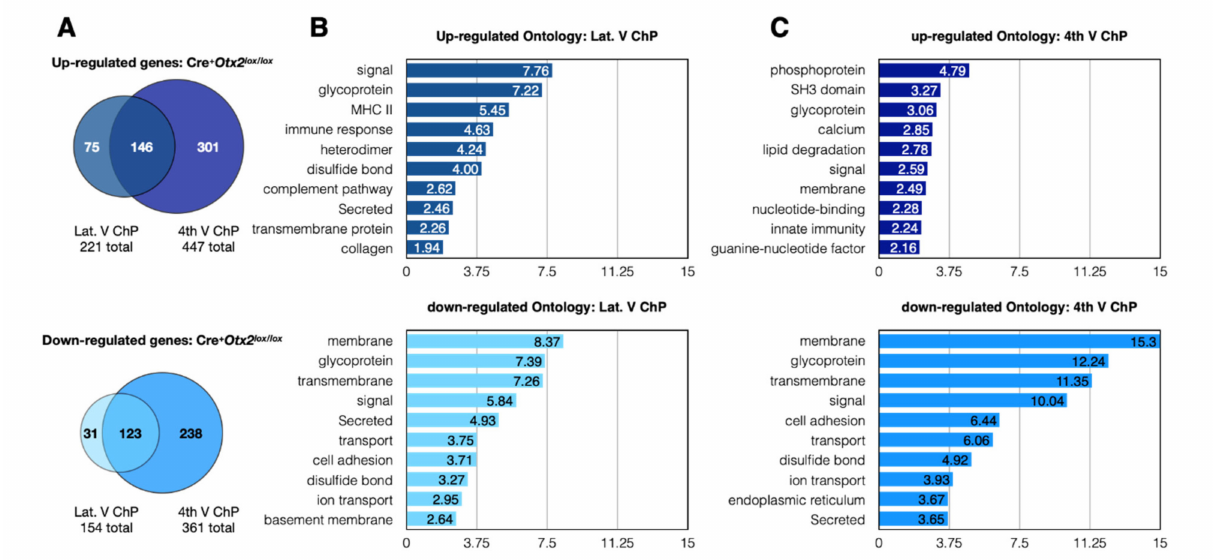
Figure 1. Changes in gene expression after conditional Otx2 knockdown in choroid plexus. ( A ) Venn diagrams of the number of up- or down-regulated genes ( p-adj < 0.05) from RNAseq analysis of ChP of Cre-Tat icv-injected Otx2 lox/lox mice (Cre + Otx2 lox/lox ) compared to vehicle-injected mice. The diagrams compare the overlap between lateral ventricle (Lat. V ChP) and fourth ventricle (4th V ChP) differentially regulated genes; ( B ) Ontology analysis of differentially regulated genes in lateral ventricle ChP after conditional Otx2 knockdown; ( C ) Ontology analysis of differentially regulated genes in fourth ventricle ChP after conditional Otx2 knockdown.